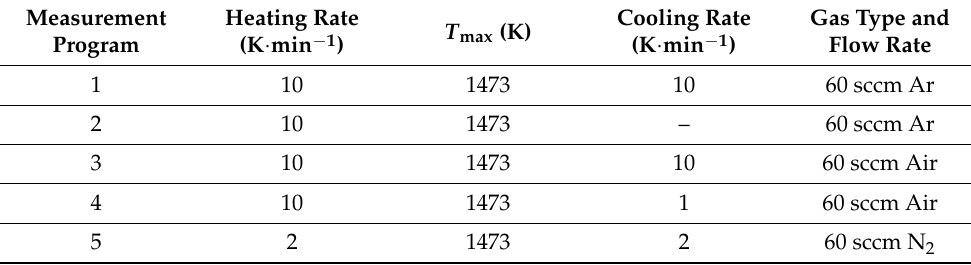
Table 1. Measurement parameters used for thermal